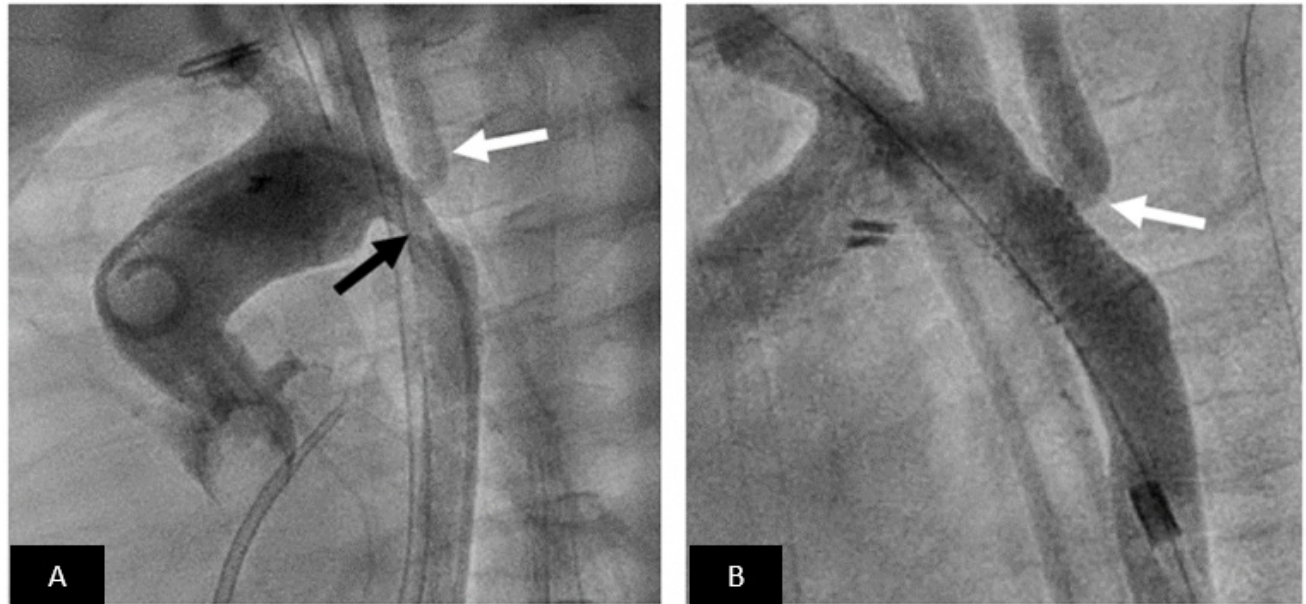
Figure 6. Coarctation stenting. ( A ) Aortogram in LAO view showing moderate coarctation (black arrow) involving the left subclavian artery (white arrow). ( B ) Excellent angiographic result following stent implantation without residual gradient. Note that even though the stent jails the left subclavian there is good flow (white arrow).